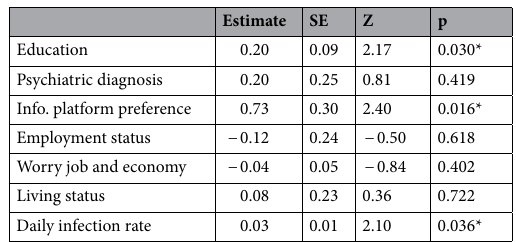
Table 1. The results of the unconditional and conditional latent change score (LCS) model of anxiety. η t1 = Latent intercept at T1 (March 2020); δη t2 = Latent change from T1-T2 (March – July, 2020); δη t3 = Latent change from T2-T3 (July – December, 2020); δη t4 = Latent change from T3-T4 (December 2020 – February, 2021); δη t5 = Latent change from T4-T5 (February – May, 2021); δη t6 = Latent change from T5-T6 (May – August, 2021); δη t7 = Latent change from T6-T7 (August—November, 2021). Age: 0 (18–30 years), 1 (31– 44 years), 2 (45–64 years), 3 (65 years and above). Sex: 0 (females), 1 (males). Education level: 0 (compulsory school), 1 (upper secondary high school), 2 (student), 3 (university degree). Preexisting psychiatric diagnosis: 0 (absence), 1 (presence). Information platform preference: 1 (unmonitored information obtainment